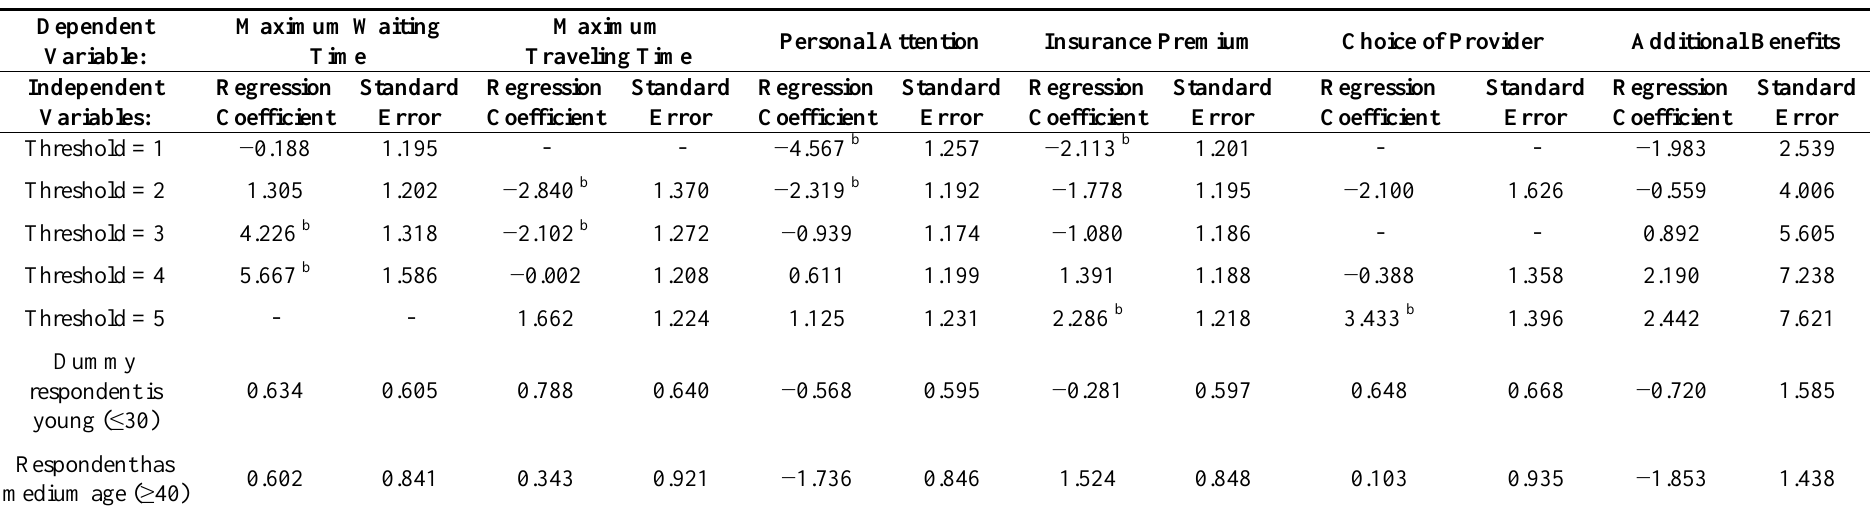
Table 6. Results from the attribute